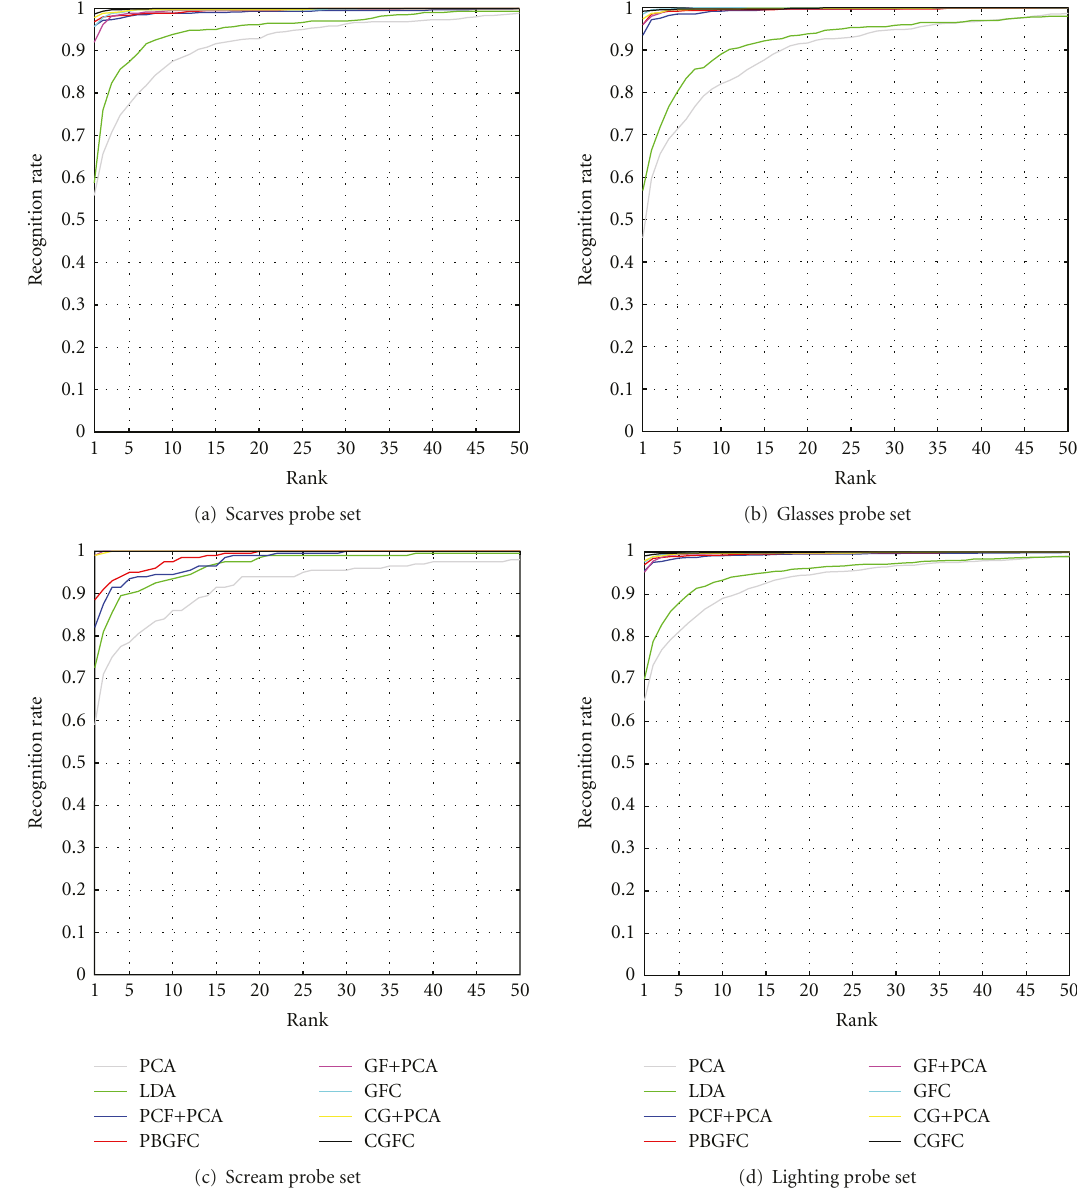
Figure 24: CMC curves obtained on the four probe sets (scarves, glasses, scream, and lighting) of the AR database.